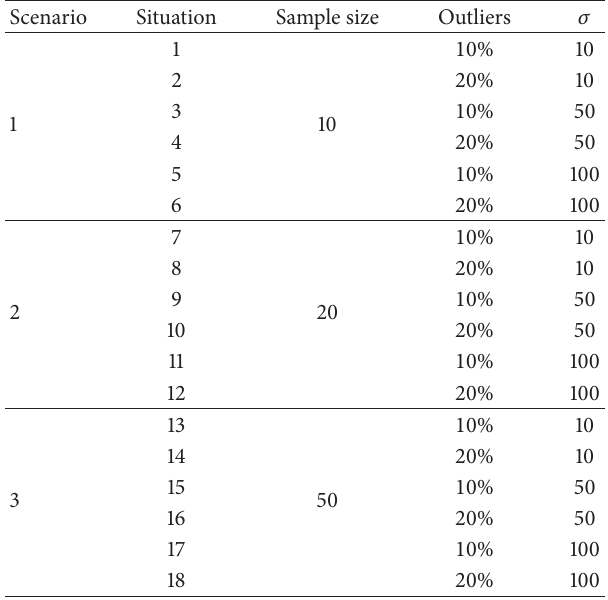
Table 1: The 18 situations considered in the